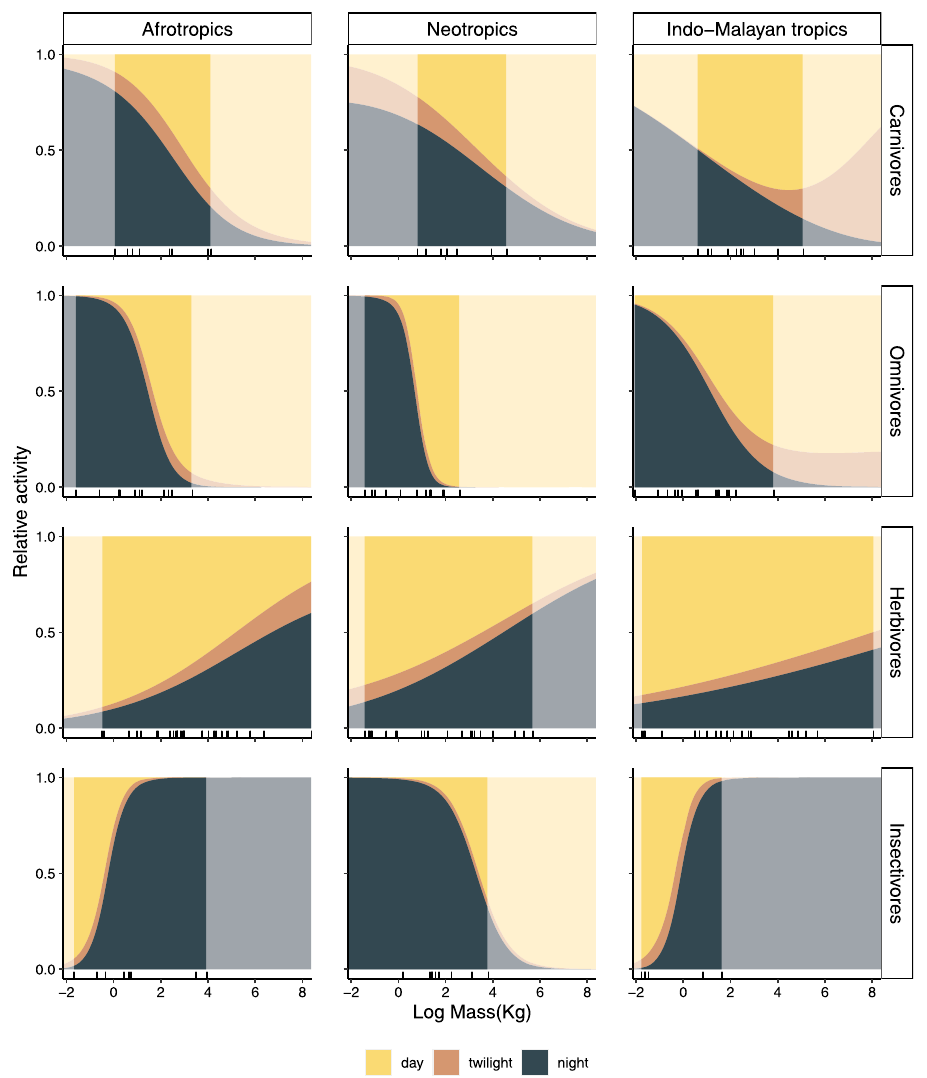
Fig. 3 | Diel activity in relation to body size and trophic guilds of tropical ground-dwelling and scansorial mammals in three regions. Estimates corre- spond to the probability of activity during the day, night, and twilight extracted from the multinomial logit models fi tted to TEAM camera-trap data ( n = 126,382). Tick marks above the x -axis indicate the body mass of species included in the analysis. Lighter colours indicate model predictions for body masses that are below or above the range for species included in the analysis